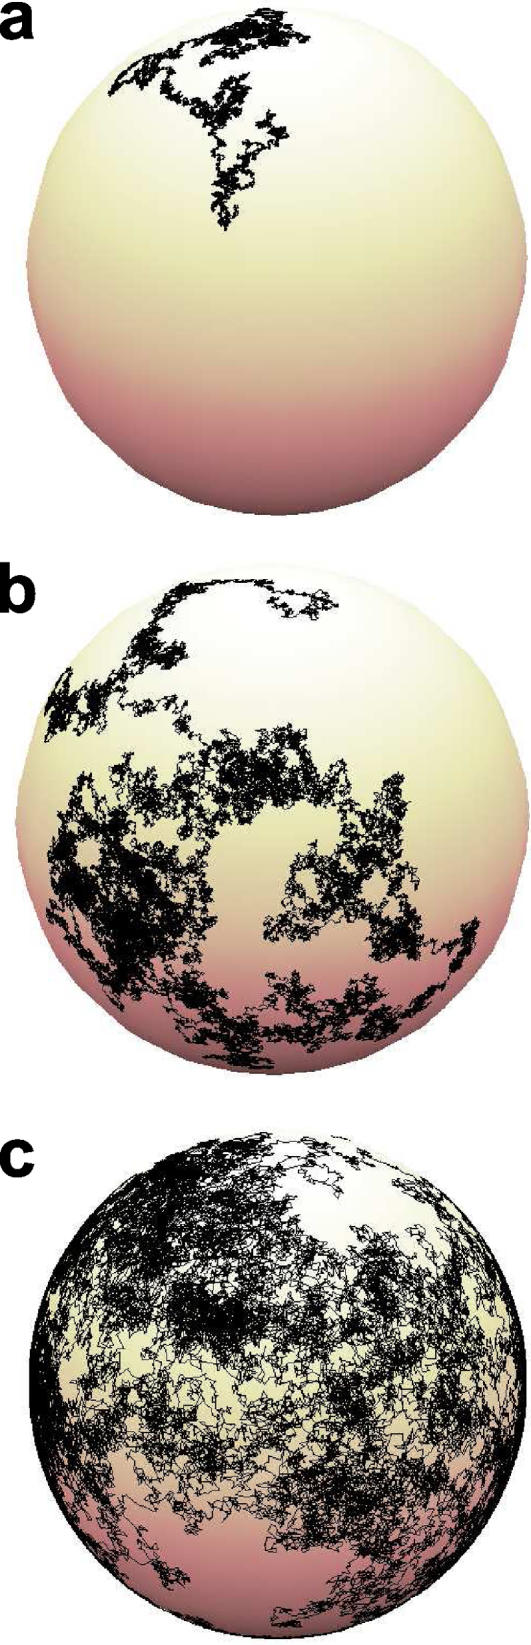
Brownian Motion on the Surface of a Spherical Cell as Given by Equation 1
Figure 1 verifies that the SDE constructed in Equation 1 correctly describes the random diffusive movement of membrane bound particles. Shown are trajectories of a diffusing particle on the surface of a cell with 10 μm radius for a fixed time with different diffusion coefficients.(A) D = 0.03 μm
2/s, (B) D = 0.3 μm
2/s, (C) D = 3 μm
2/s.